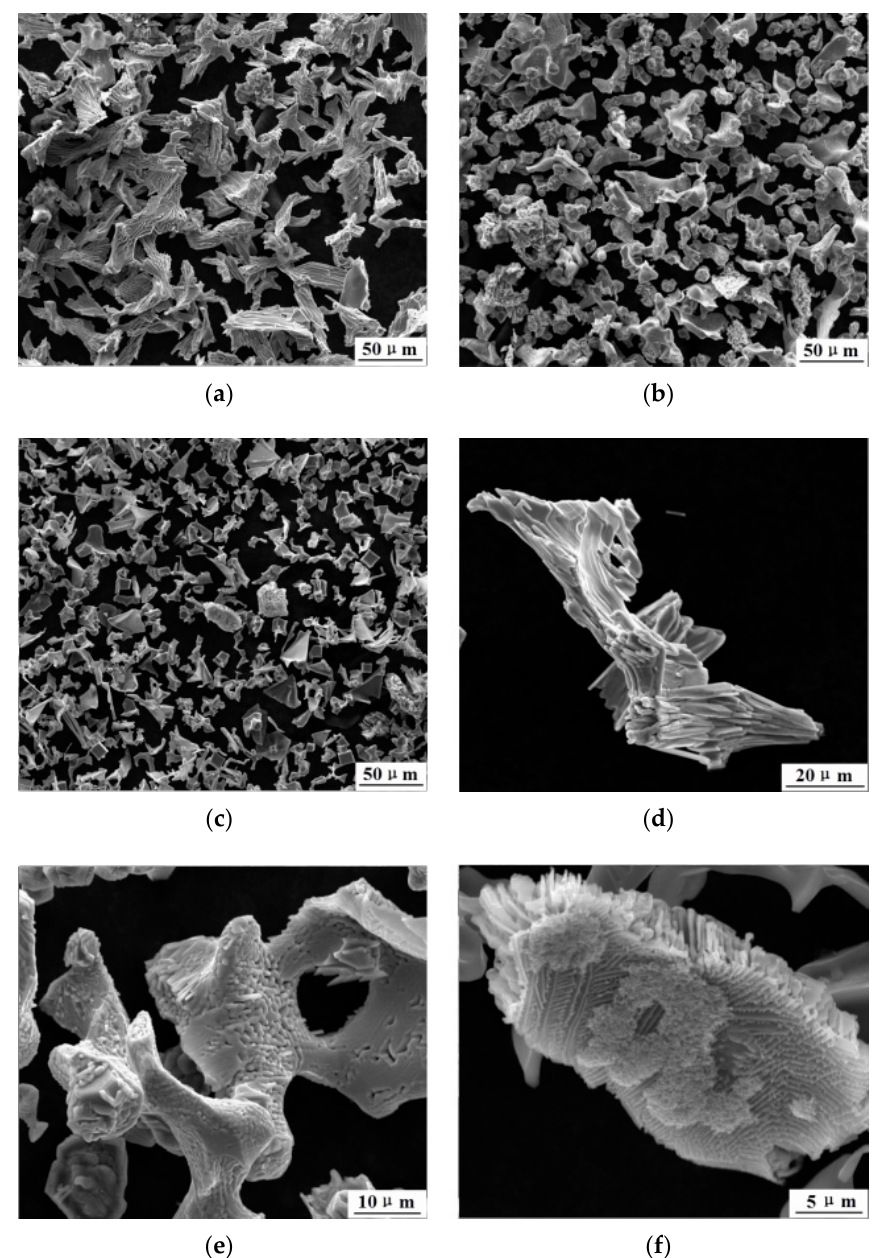
Figure 7. SEM images of carbides power: ( a ) and ( d ) sample No. 1; ( b ) and ( e ) sample No. 2; ( c ) and ( f ) sample No. 3.